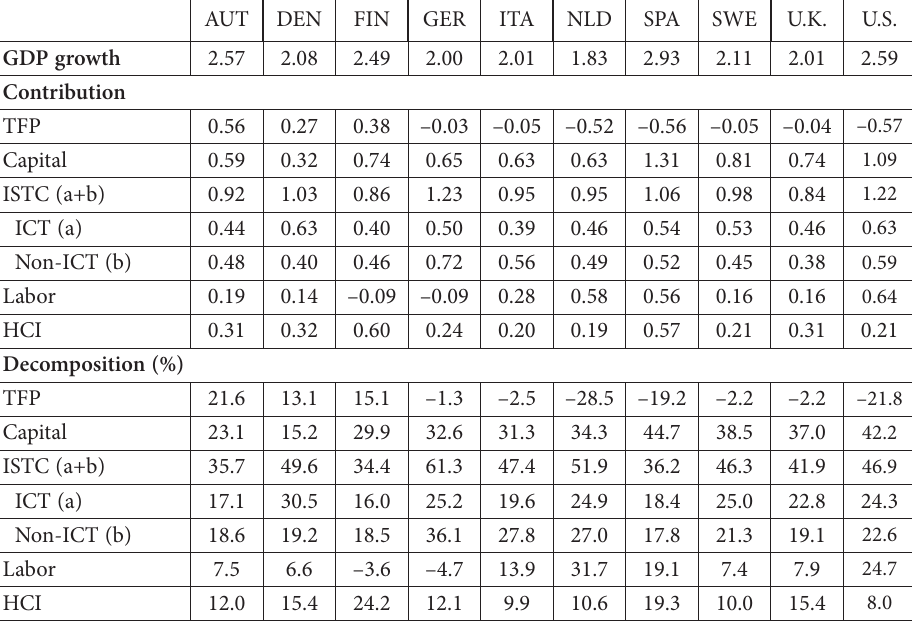
Table 6. Hulten’s method. GDP Growth Decomposition,